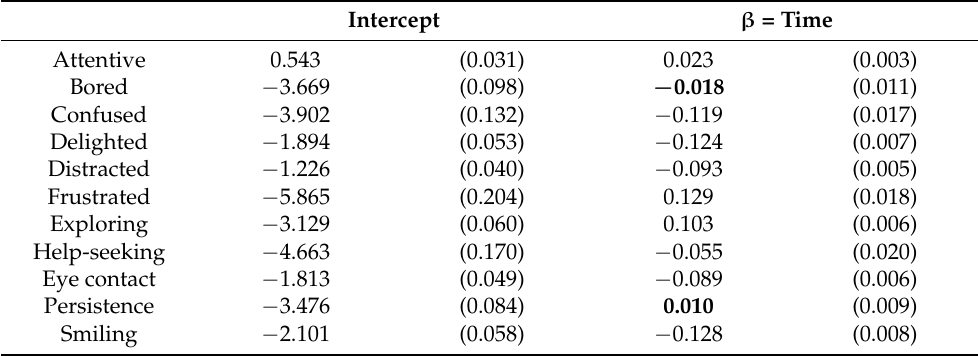
Table 4. Changes in behavior and affect states over time.